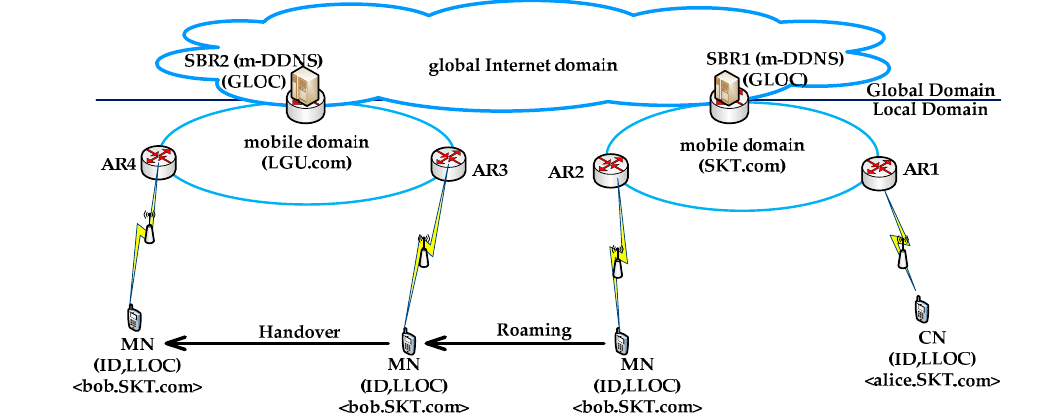
Figure 5. Mobility scenario for ILNP-Distributed scheme. Table 1. Home Host Register (HHR) in SKT.com domain.